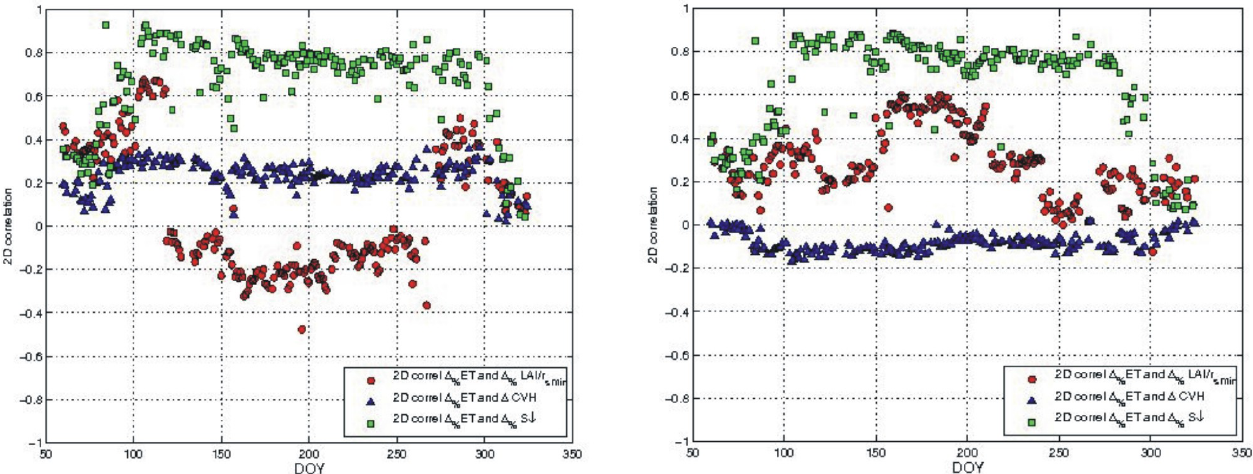
Fig. 8. Spatial (2-D) correlation over Europe between the ET mean relative bias (based on the images between 09:00 to 12:00 UTC) and model differences: (1) LAI/ r s min (red diamonds), (2) High vegetation percentage (CVH, blue triangles), and (3) S ↓ mean relative bias (DSSF, green squares). At left: comparison between LSA SAF MET and ECMWF. At right: comparison between LSA SAF MET and